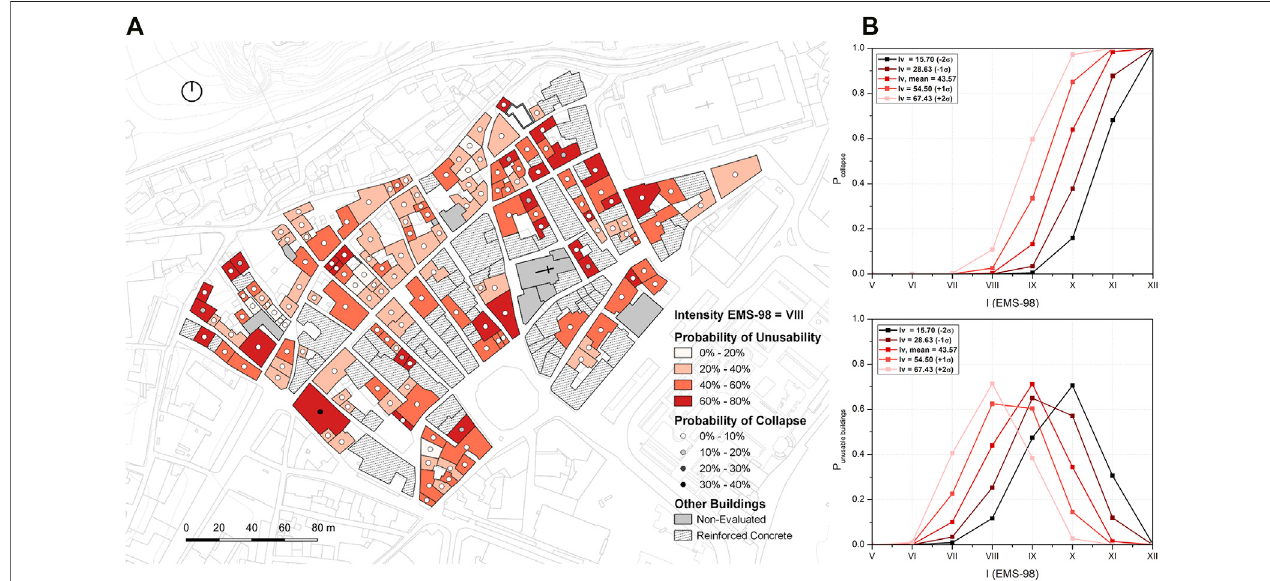
FIGURE5| MappingoftheprobabilityofcollapsesforanintensityVIIIinthe1998European MacroseismicScale(EMS-98) (A) ,and collapseandbuildingunusable probability curves obtained from the mean value of the vulnerability distribution (B) . For details on how these outputs were obtained please refer to Blyth et al. (2020).